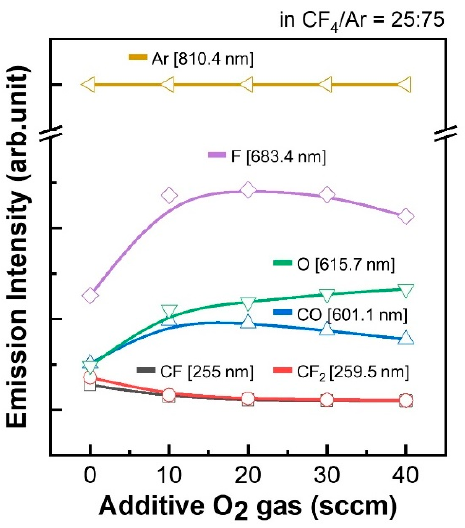
Figure 2. Results of OES analysis as a function of additive O 2 gas flow rate with fixed CF 4 /Ar = 25:75 sccm. Table 1. Electron-impact and gas-phase reactions in O 2 /CF 4 /Ar plasma.